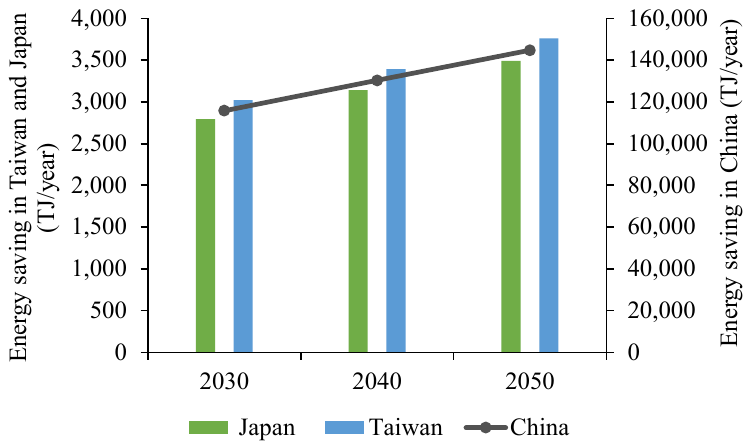
Figure 21. Total combined annual energy saving after electrification of all seven studied textile wet processes.